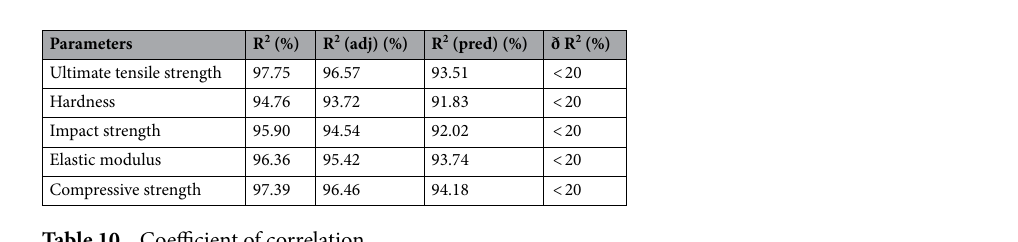
Table 10. Coefficient of